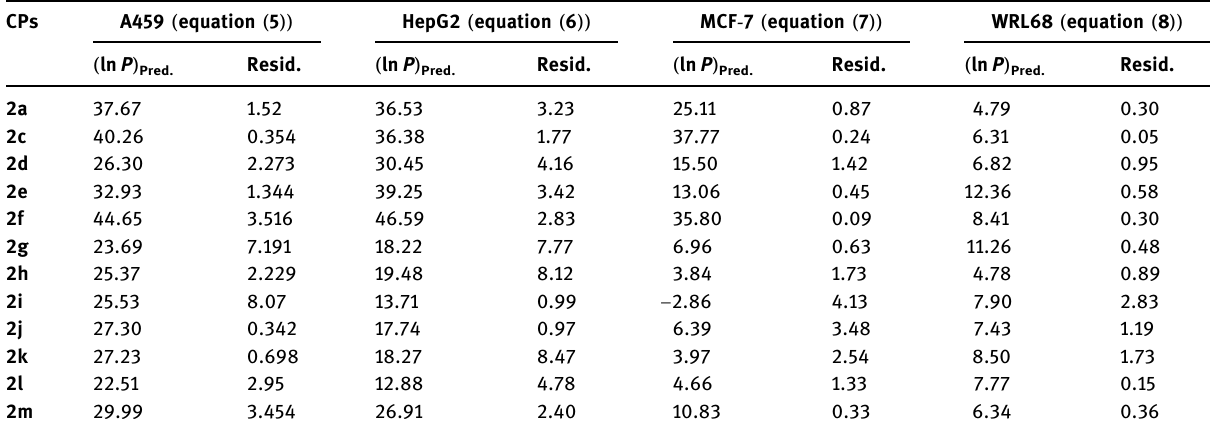
Table 9: Predicted percentage inhibition and residuals obtained by using MLR equations ( 5 ) – ( 8 ) and considering compounds 2a and 2c – 2m CPs A459 ( equation ( 5 )) HepG2 ( equation ( 6 )) MCF - 7 ( equation ( 7 )) WRL68 ( equation ( 8 )) ( ln P ) ( ln P ) ( ln P ) ( ln P ) Pred. Resid. Pred. Resid. Pred. Resid. Pred. Resid.